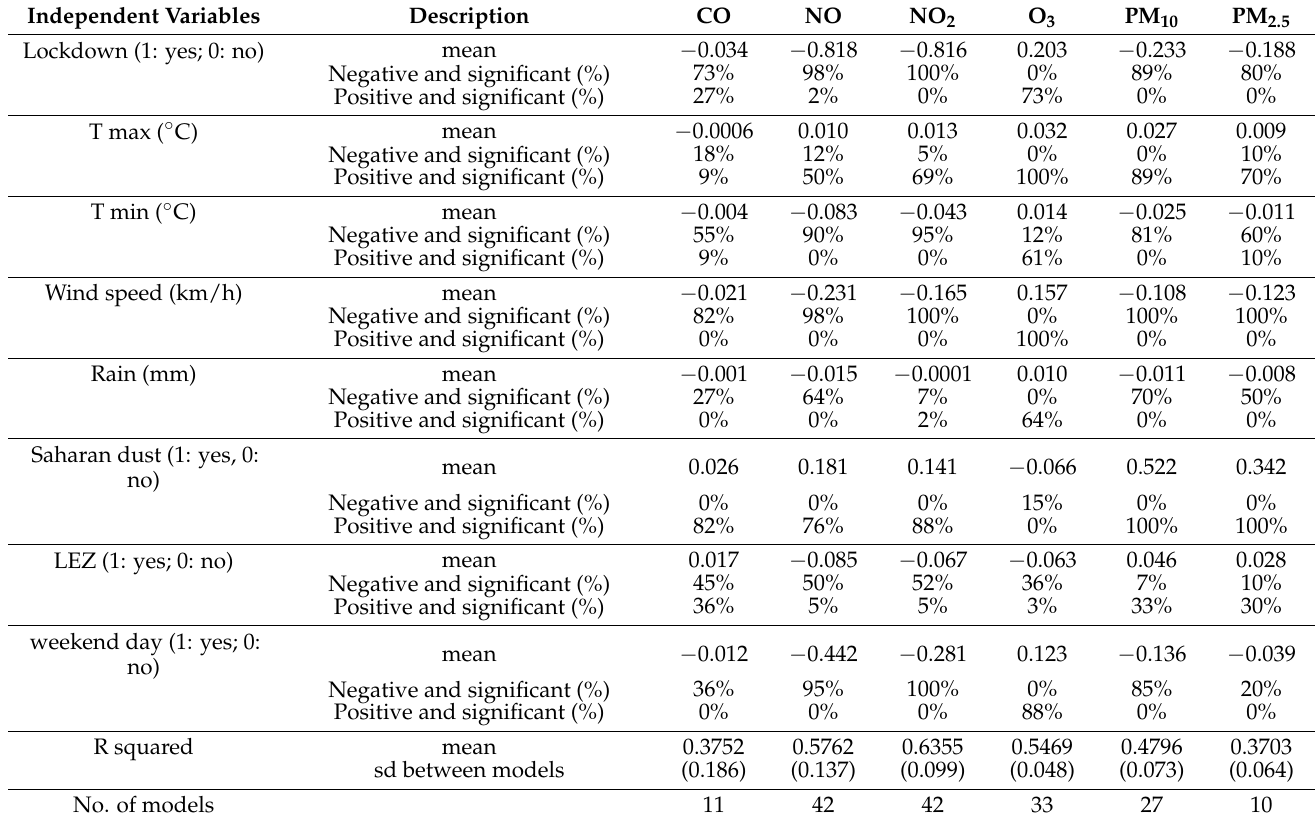
Table 1. Regression results by pollutant. Columns 3 to 8 display the estimated mean coefficients between the regression models of each independent variable (independent variable column) relative to each dependent variable (pollutant). Independent Variables